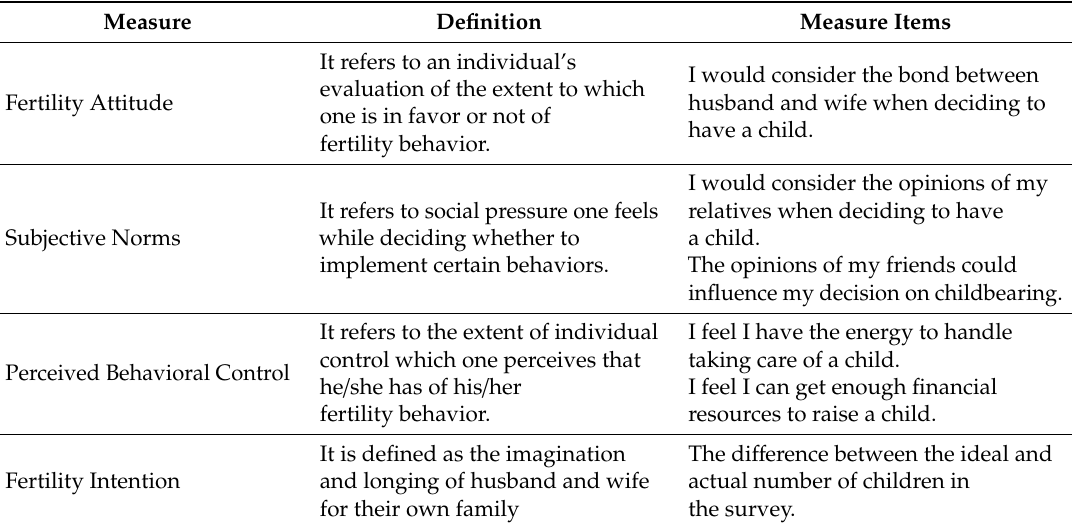
Table 1. The measurement items and relevant